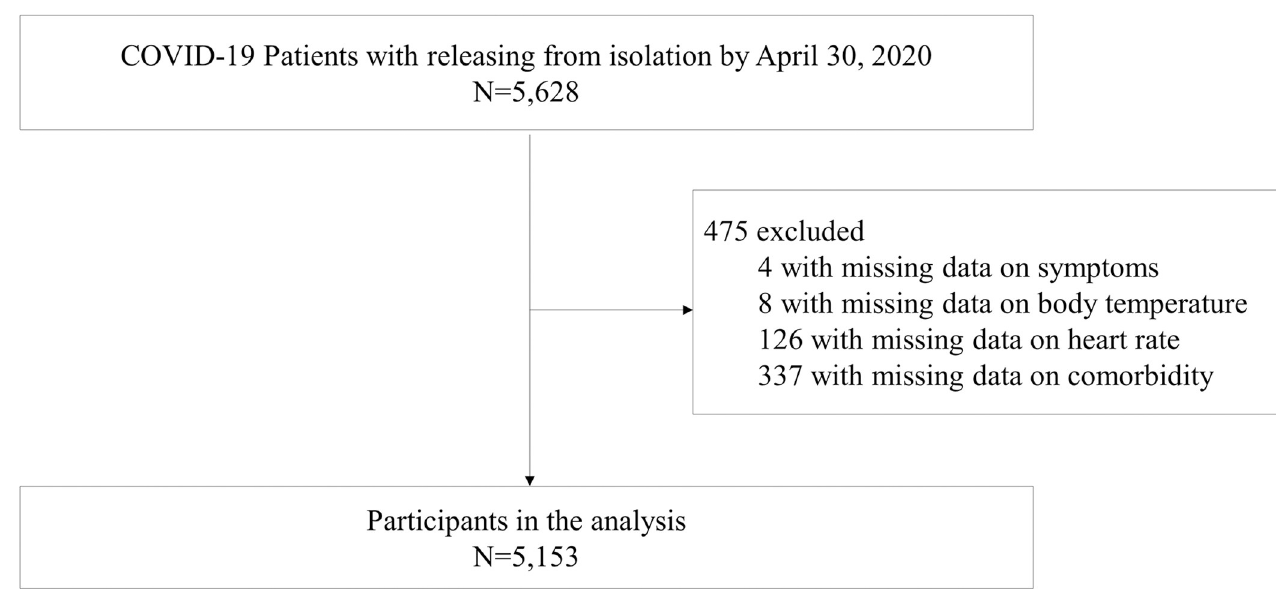
Fig 1. Study flow